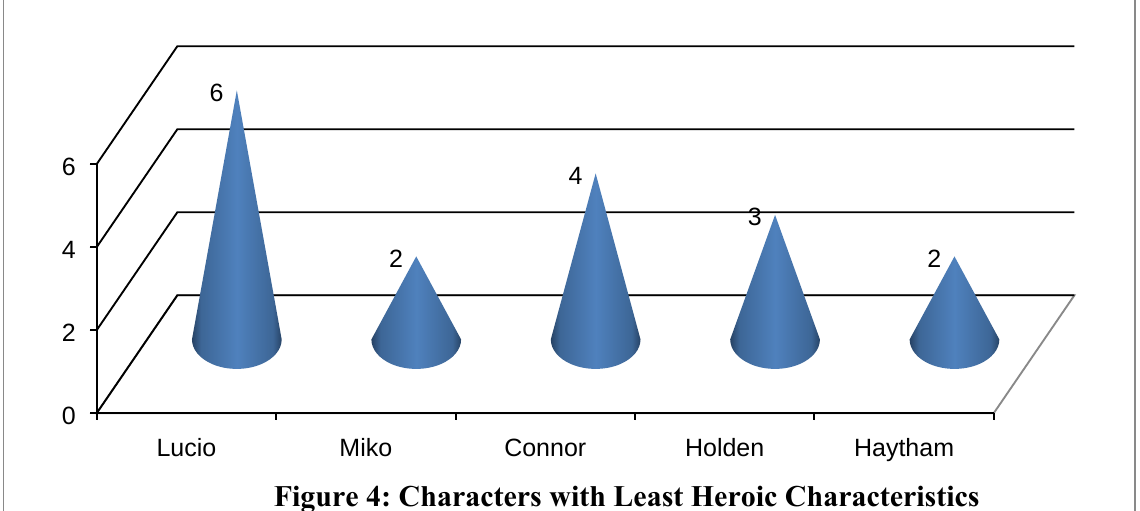
Figure 4: Characters with Least Heroic Characteristics